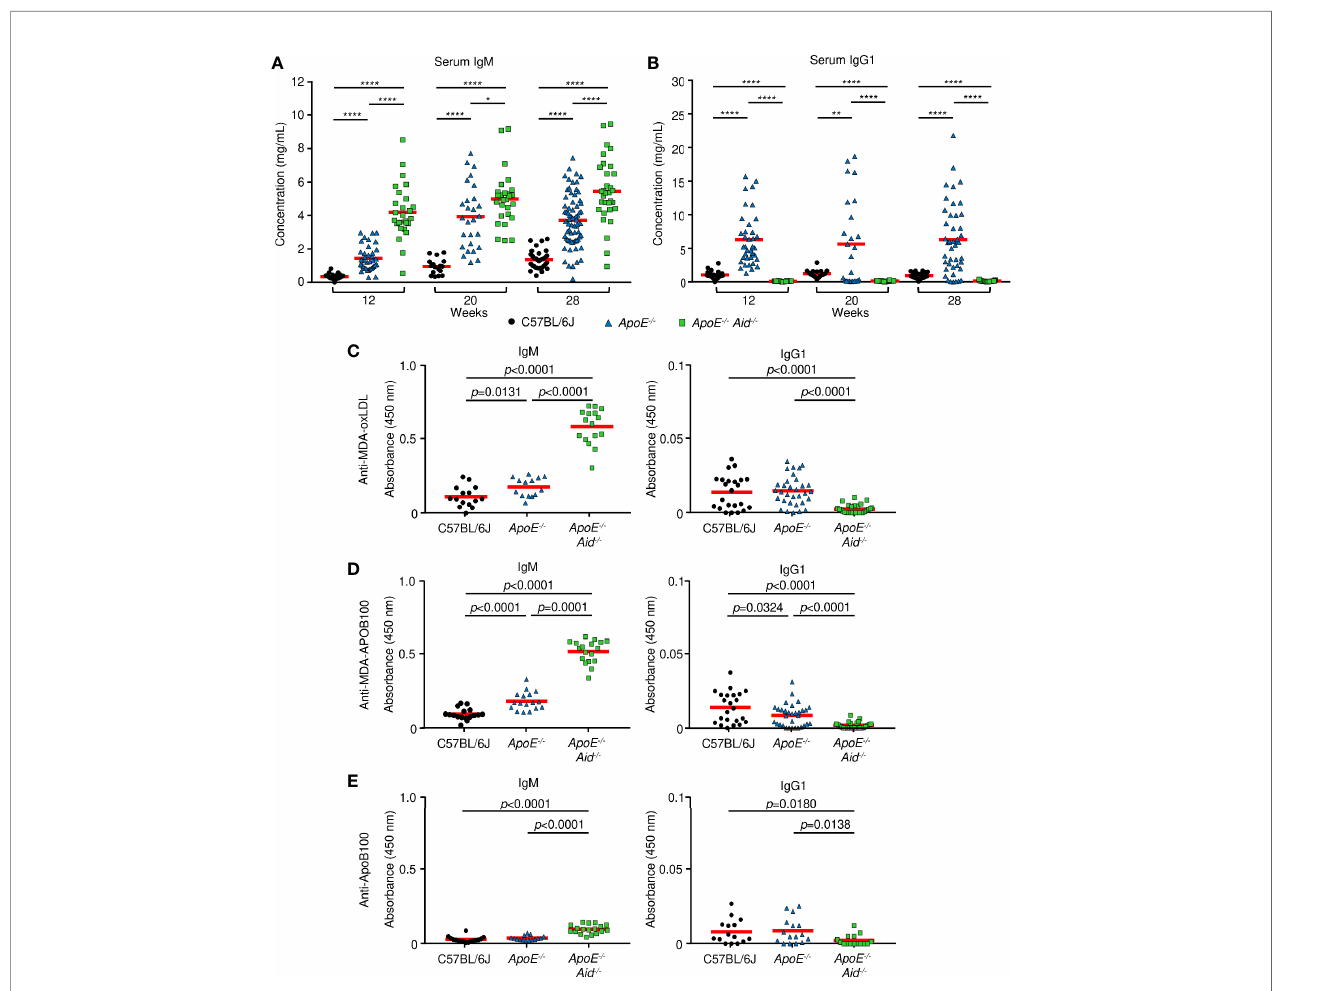
FIGURE 3 | Serum antibody concentrations from mice. (A, B) total immunoglobulin measured by ELISA at 12, 20 and 28 weeks on a high fat diet. (A) IgM and (B) IgG1 from C57BL/6J (black circle), ApoE -/- (blue triangle) or ApoE -/- Aid -/- (green square) mice. Red line represents the mean from 17 or more independent mice. *0.05 > p > 0.01, **0.01 > p > 0.001, ***0.001 > p > 0.0001, ****p < 0.0001. (C – E) , IgM and IgG1 antibody titers measured by ELISA at 28 weeks on the diet. (C) MDA-oxLDL, (D) MDA-ApoB100, and (E) ApoB100. IgM sera was diluted 1:1000, and IgG1 sera was diluted 1:200 for analysis. Symbols represent percentages in individual mice with red line displaying the mean from 14-16 mice per genotype. Signi fi cance was determined by two-tailed